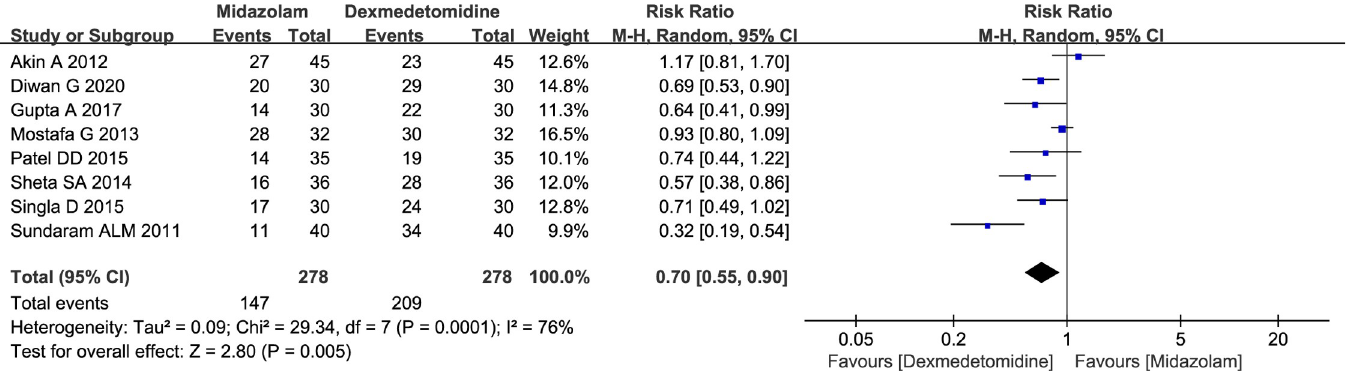
Fig 3. Forest plot depicting the meta-analysis for the outcome “number of patients with satisfactory separation from parents” for intranasal midazolam versus intranasal dexmedetomidine.